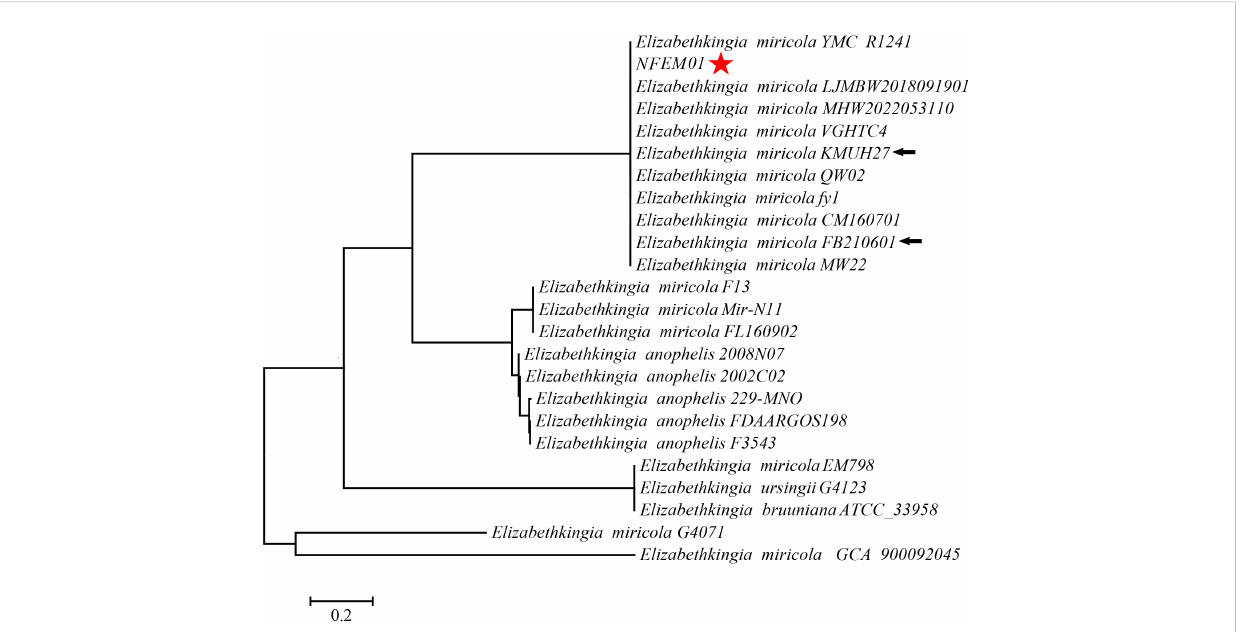
FIGURE 3 A phylogenetic tree was constructed based on the 16S rRNA gene of NFEM01 by neighbor-joining method and displays the percentage of bootstrap values on each branch point (1000 copies). The scale represents 0.02 nucleotide substitutions each site. Star refers to the strain from this study. The arrow stands for the type strain of the